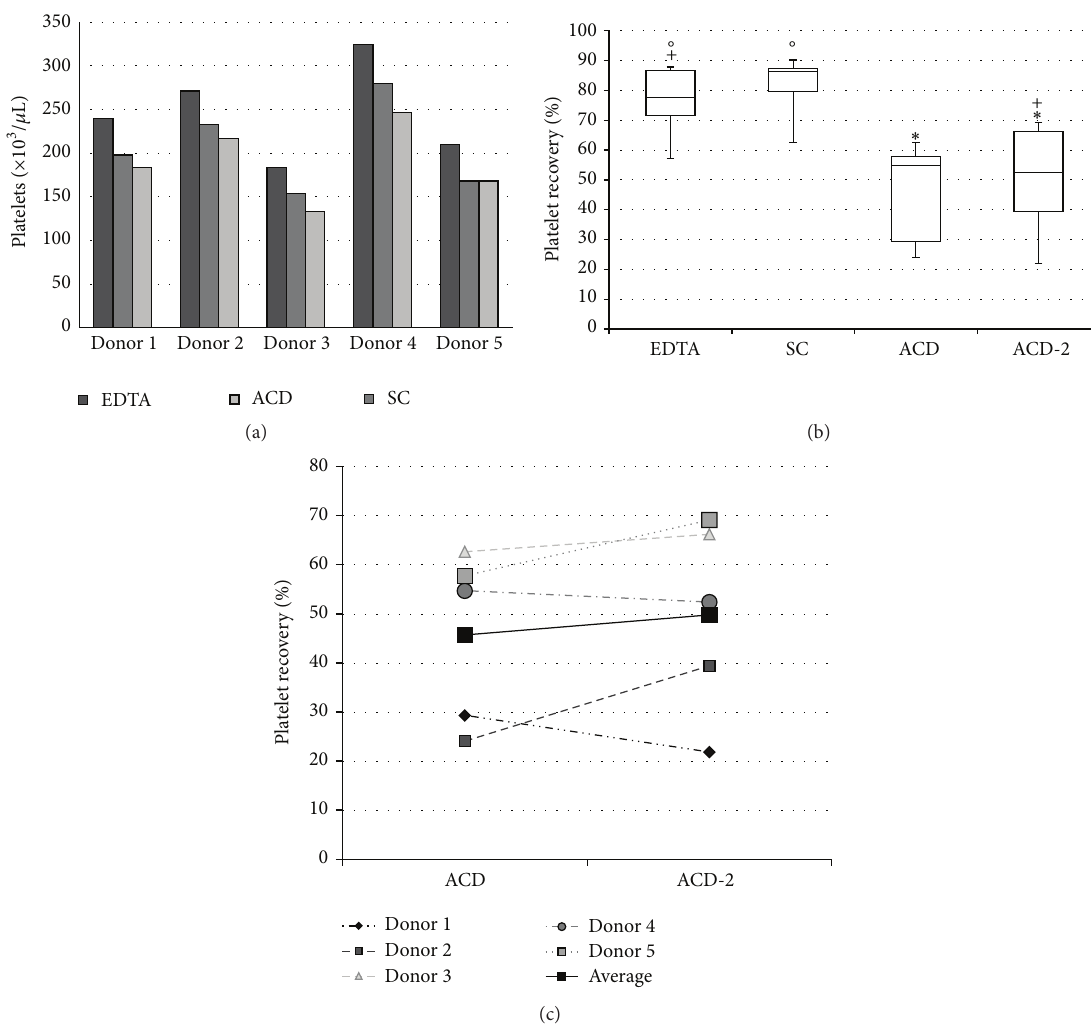
Figure 1: Platelet yield and recovery in blood collected with different anticoagulants. Blood was collected in EDTA, SC, and ACD in five different donors and platelet concentration was quantified (a) as well as platelet recovery after the first centrifugation step (b). An individual analysis between ACD and ACD-2 of platelet recovery was also performed (c). Data are expressed as bar (a), box (b), and dot (c) plots. Similar symbols in (b) correspond to statistic similarity among groups ( 𝑝 >